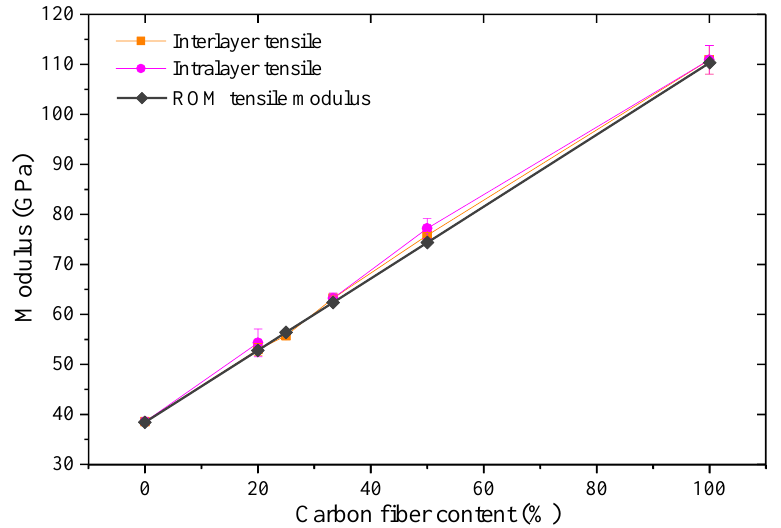
Figure 21. Comparison of experimental and theoretical tensile modulus.